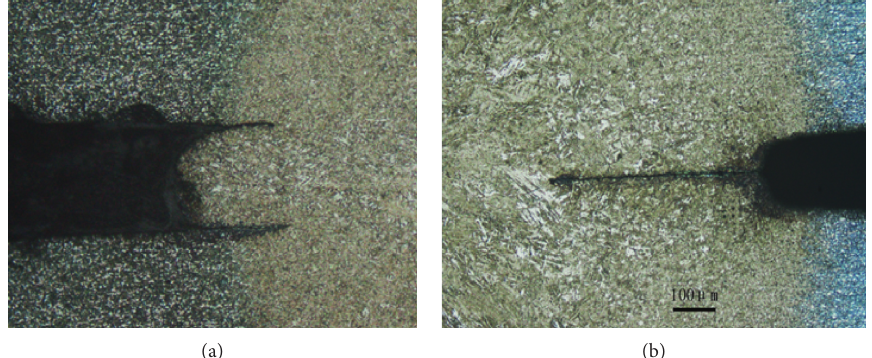
Figure 9: Weld line. (a) QP980 steel RSW; (b) TRIP800 steel RSW.